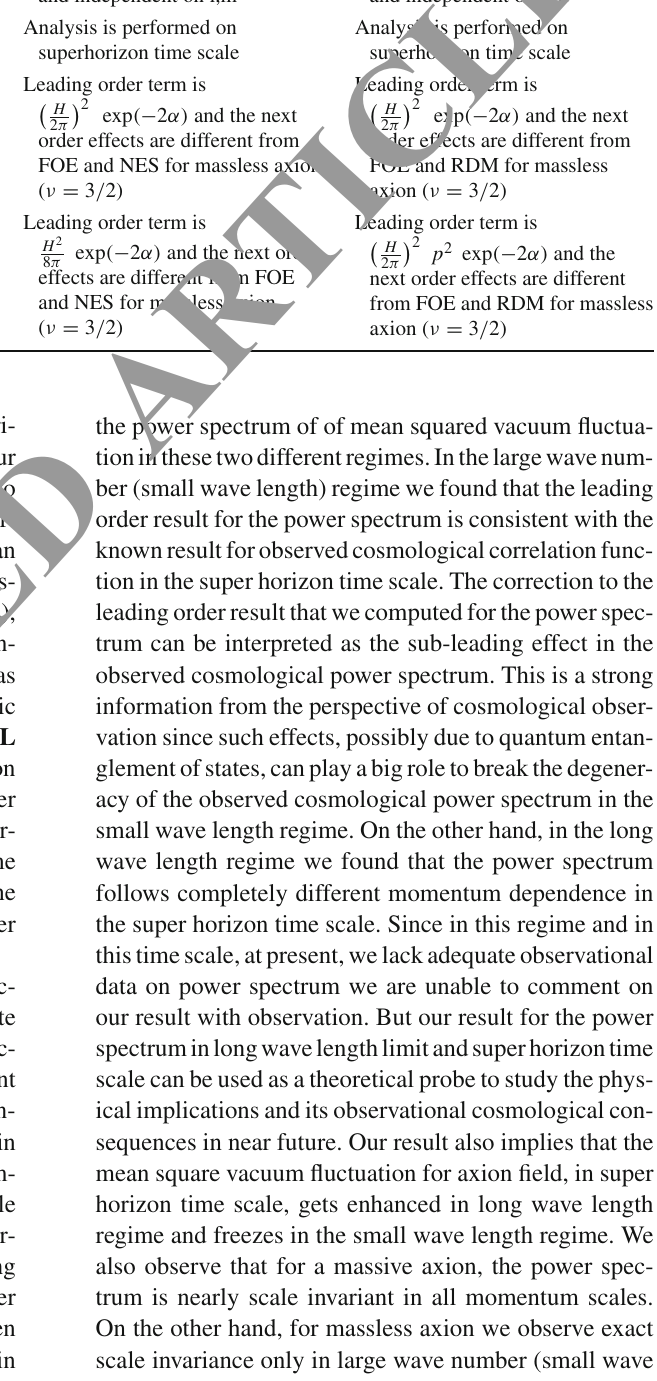
Here we solve the wave function in L and R region of dS space Here we deal with mixed quantum state Power spectrum is only dependent on SO(1,3) quantum number p and independent on l,m superhorizon time scale